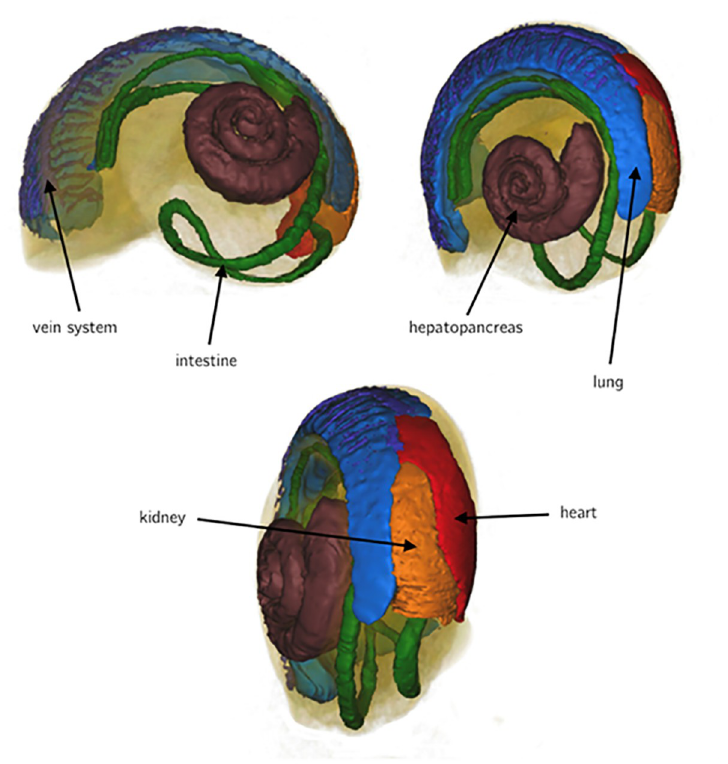
Fig 6. Reconstructed organs of X . derbentina and volume